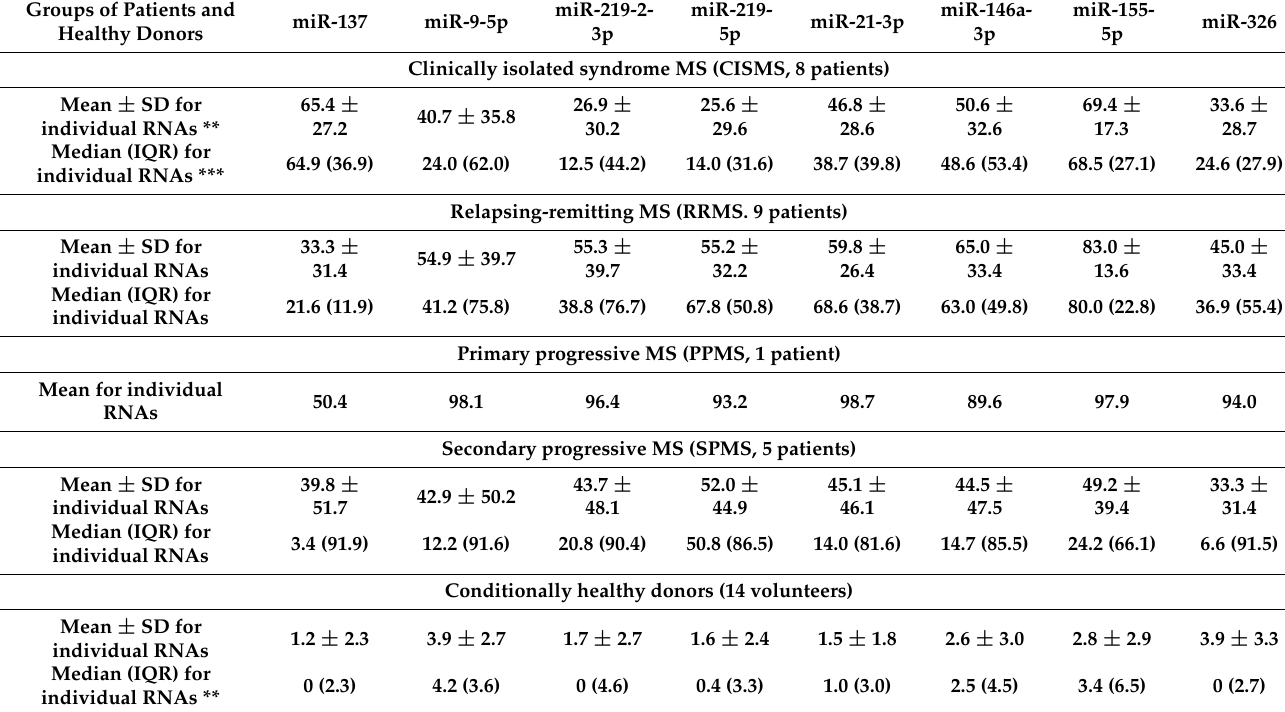
Table 1. Average relative activities (%) of polyclonal IgGs from the sera of MS patients and conditionally healthy donors in the hydrolysis of eight different